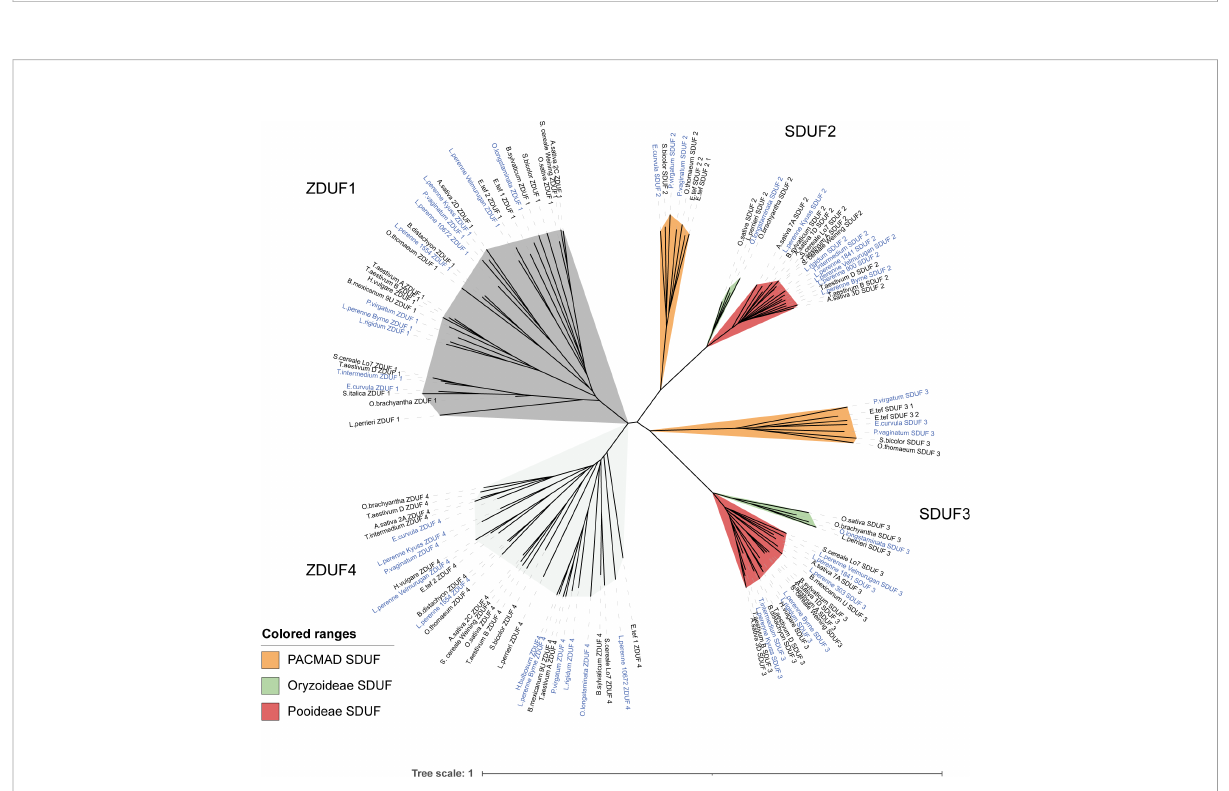
FIGURE 6 Phylogeny of S/Z-DUF247 genes from various grass species. A phylogenetic tree constructed using the sequences of all S/Z-DUF247 protein sequences. To produce the tree a global alignment with a BLOSUM62 cost matrix was performed, followed by tree building using a Jukes Cantor genetic distance model and nearest neighbor tree-building method. Subclades of SDUF2 and SDUF3 based on subfamily are shown. ZDUF1/ZDUF4 did not produce subclades. Self-incompatible species are highlighted with blue text. Scale bar indicates substitutions per